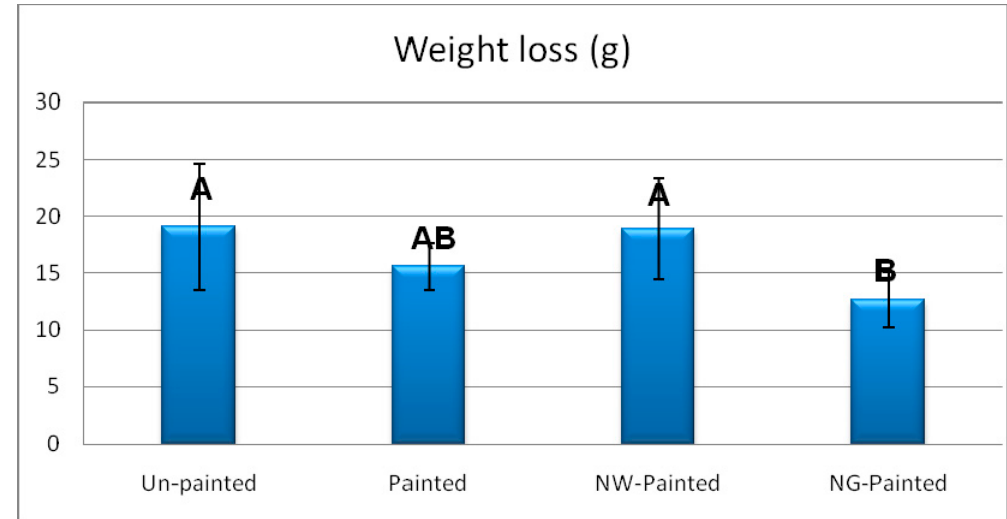
Figure 7. Burnt area and weight loss in the four treatments of beech specimens (NW = nanowollastonite; NG = nano-graphene) (Letters on each column represent Duncan groupings at 95% level of confidence.).